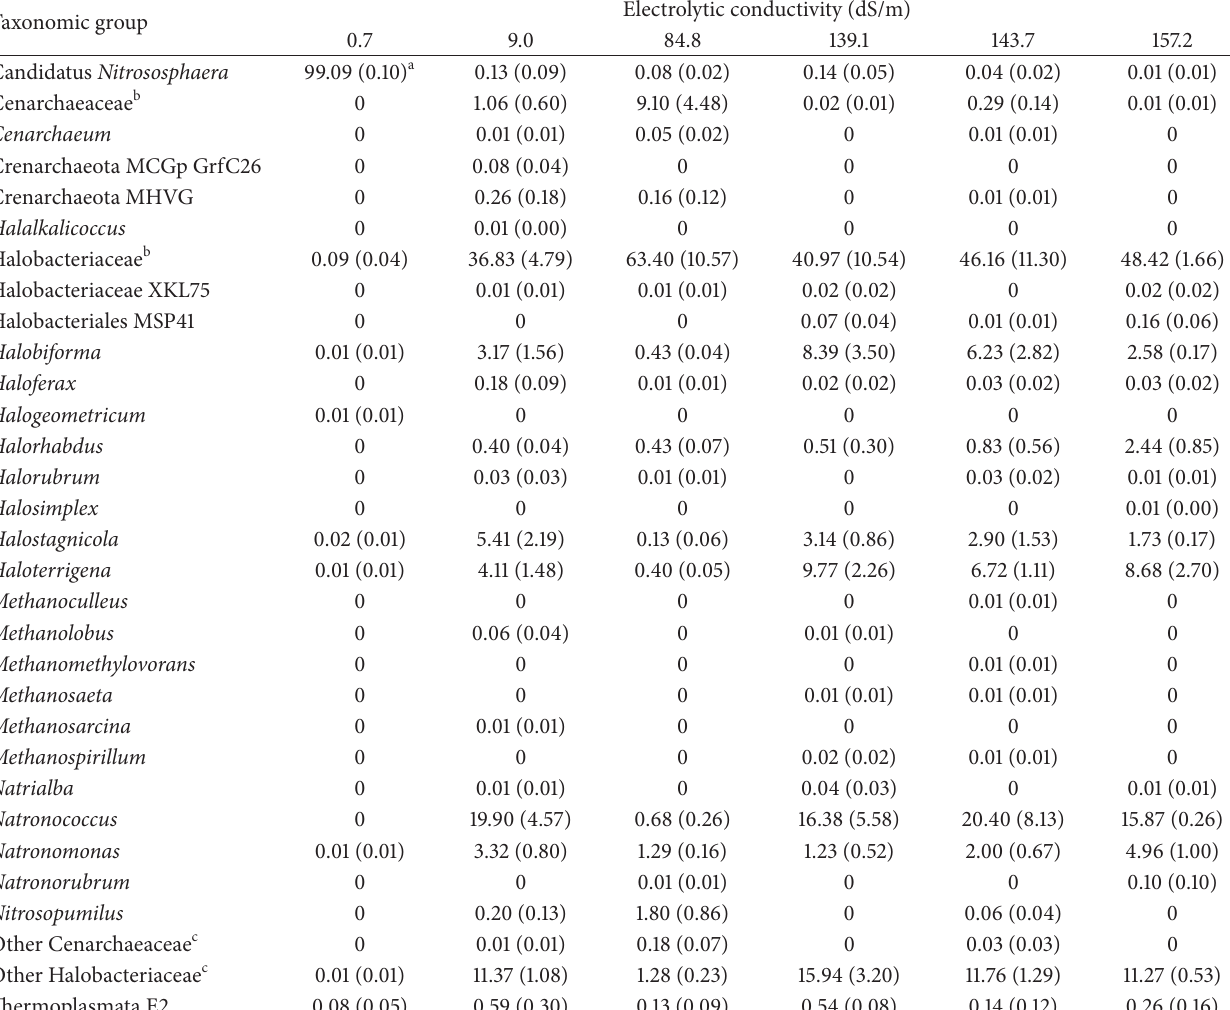
Table 2: Relative abundance of the taxonomic affiliations at genus level of the archaeal communities of soils from the former lake Texcoco. Taxonomic